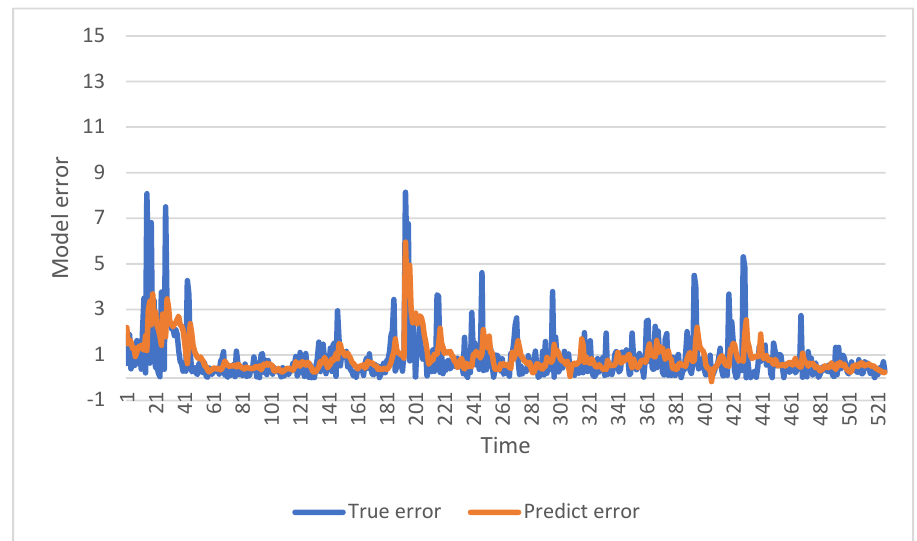
Figure 5. Comparison of the predicted errors with actual errors.